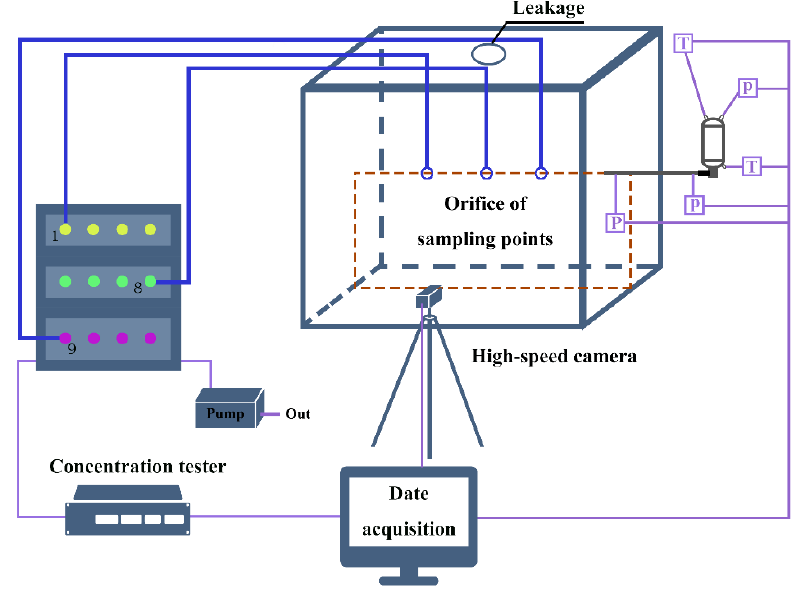
Figure 1. The full-scale airborne fire extinguishing system.